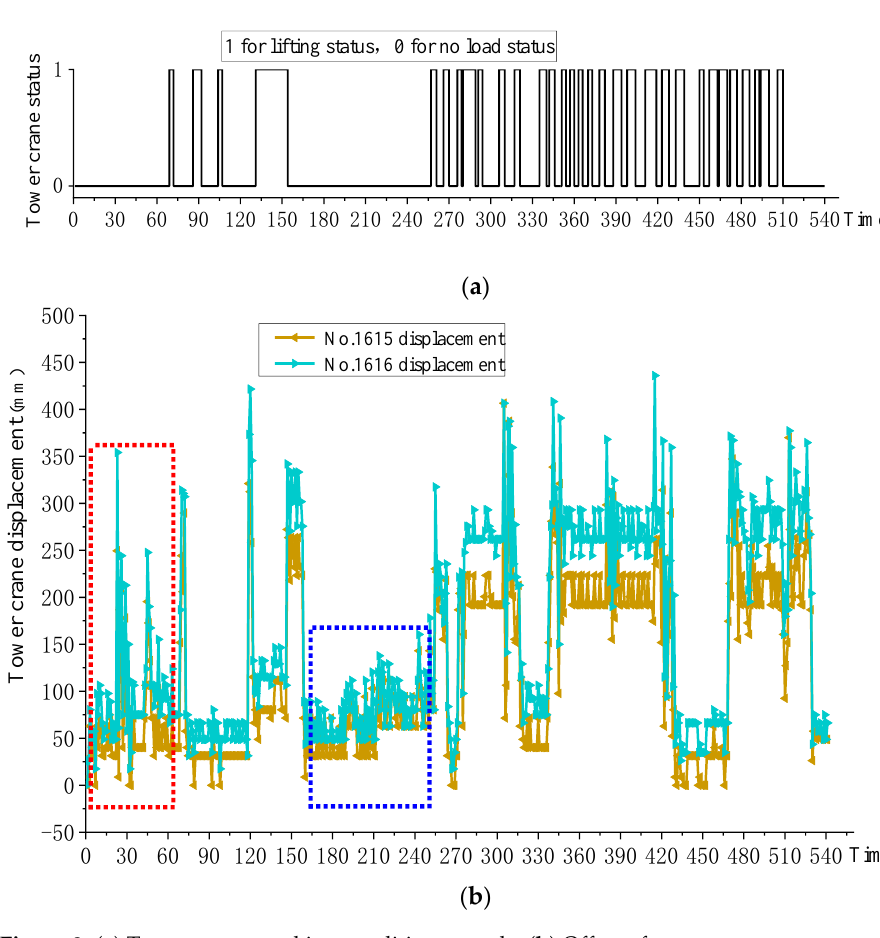
Figure 8. ( a ) Tower crane working condition records. ( b ) Offset of tower crane measurement points.